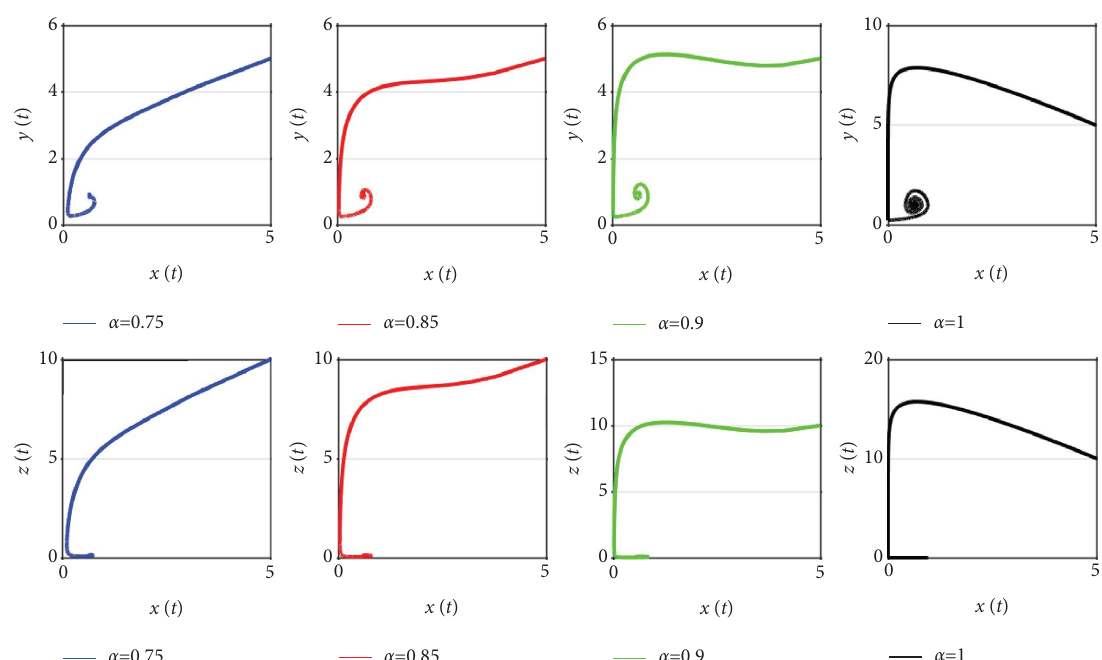
Figure 9: Phase space for the one prey-two predators system, where D ( x ) � 0 , G ( y ) � g / y � 0 . 01/ y, J ( z ) � 0 , a � b � c � 0 . 1 , e � h � 0 . 3 , f � i � 0 . 2 , and α � 0 . 75 , 0 . 85 , 0 . 9 , 1